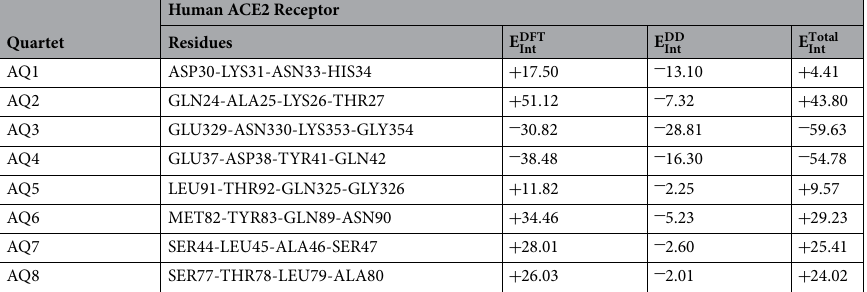
Table 2. Human ACE2 receptor (hACE2) quartets and their interaction energies [kcal/mol] b neighboring S-RBD residues. a DFT energies computed at 6-311+G(d,p)/B3LYP level; Dispersion (DD) corrections evaluated with semiempirical method 27 . b All S-RBD residues within 4.5 Å of each ACE2 quartet were included.